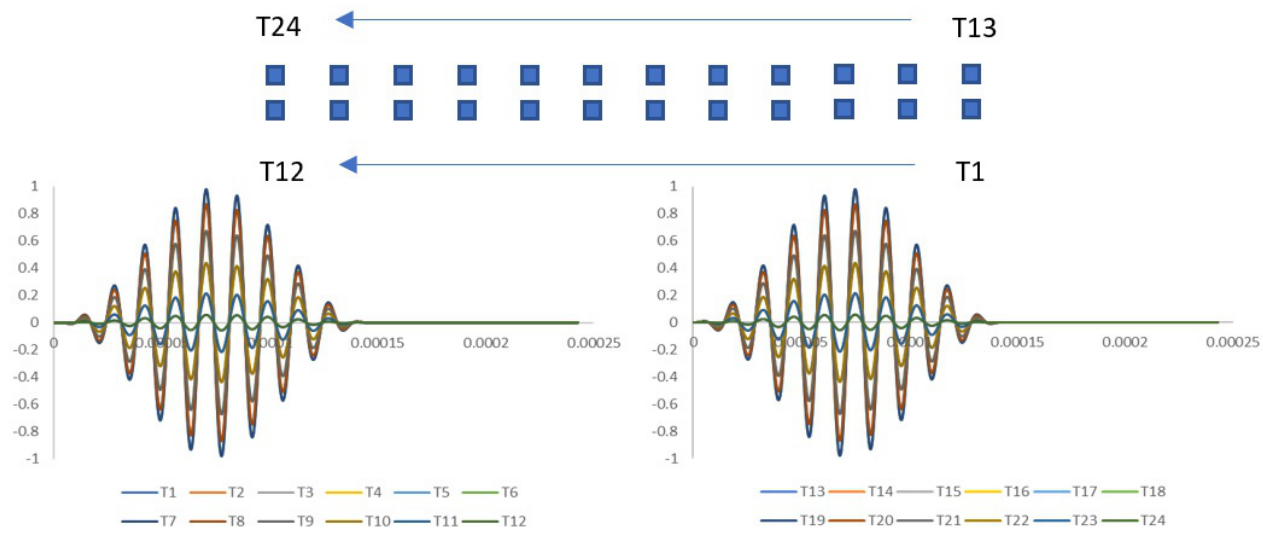
Figure 10. Apodisation of the amplitude of the excitation signal applied across each row of 12 × 2 array transduction points.